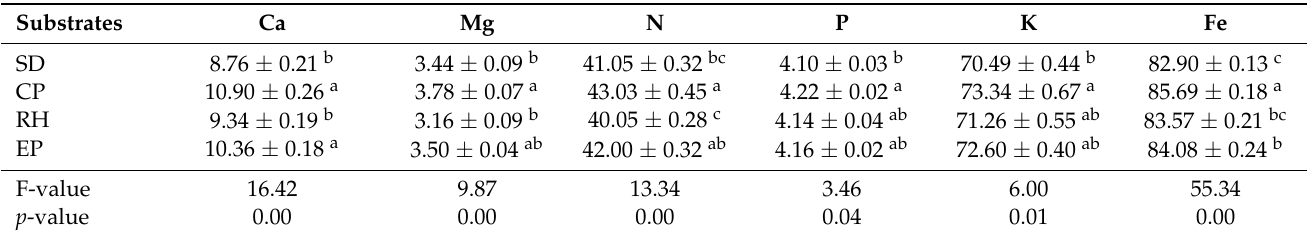
Table 8. Nutrient balance in lettuce leaf under different growing substrate